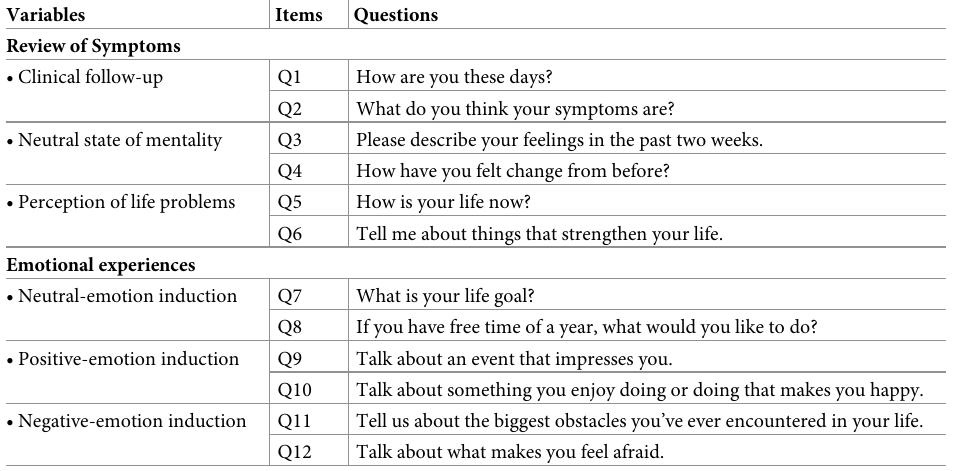
Table 1. The developed thai depression assessment tasks [43].